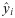
Workflow for comparing parameter-dependent simulated data with measured clone abundances.The first step is drawing a configuration {hi}, which is experimentally unmeasurable, from the HSC clone distribution P(h). To define P(h) requires an initial estimate of λ and Ch. Using known experimental parameters θexp and choosing rn, Le ∈ θmodel, we compute the theoretical quantities yi and zi by simulating the multi-compartment mechanistic model and the peripheral-blood sampling. The corresponding y^i and z^i are extracted from data, and the theoretical Yz(θmodel) and the experimental Y^z are compared through the MSE defined in Eq (16). The MSE is then minimized to find least squares estimates for θmodel.